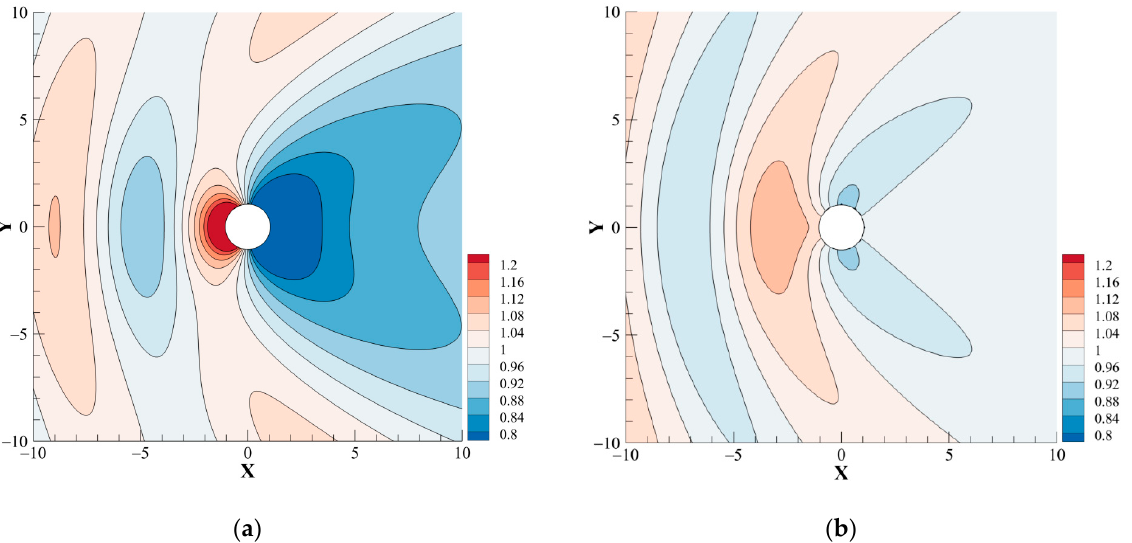
Figure 6. Dimensionless wave amplitude responses of an isolated WEC: ( a ) 5-DOF WEC; ( b ) heaving WEC.